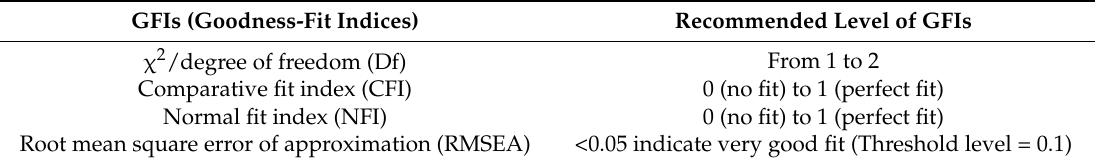
Table 5. The recommended level of goodness-fit indices (GFIs) measures.